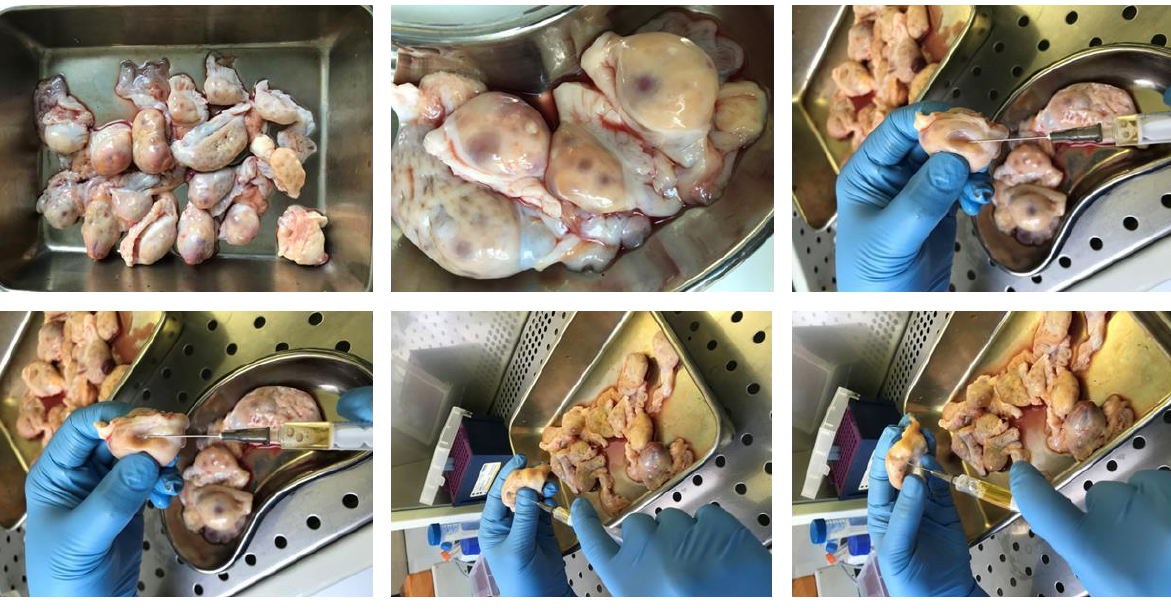
Figure 1 . Needle aspiration of cumulus-oocyte